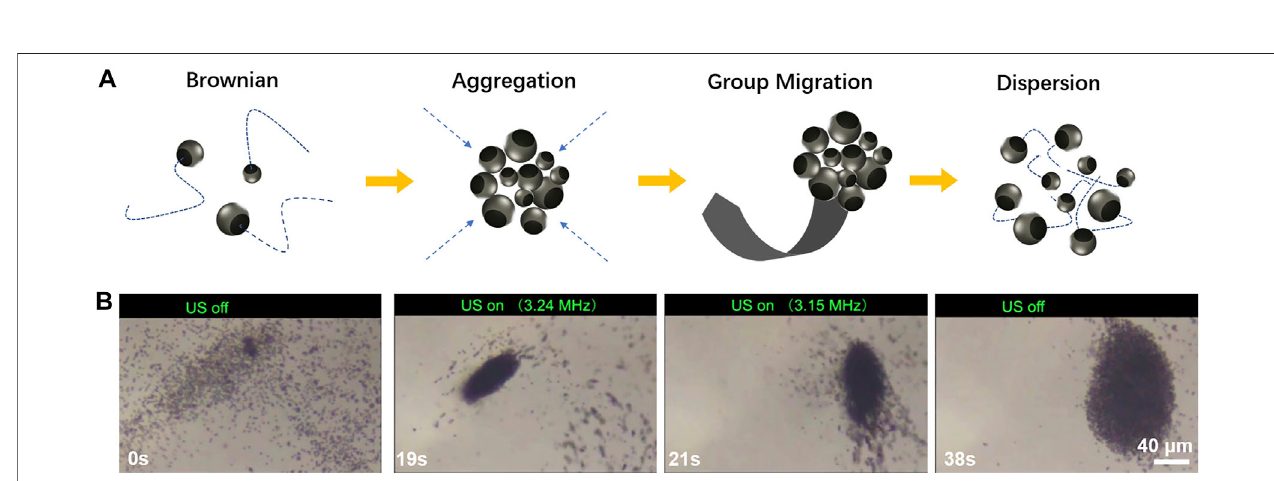
FIGURE 5 | (A) Schematic of group motion behavior of the hybrid micromotors. (B) The time lapse images of the micromotors group motion control (taken from Supplementary Video S3 ).